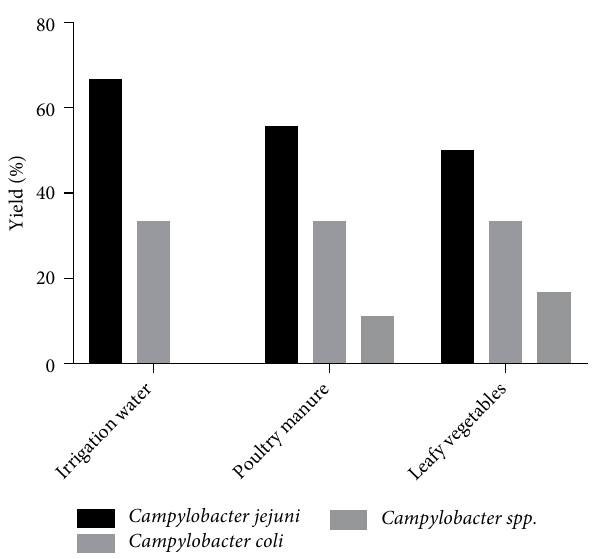
Figure 2: Distribution of Campylobacter species by to NPK Gardens contaminated samples.